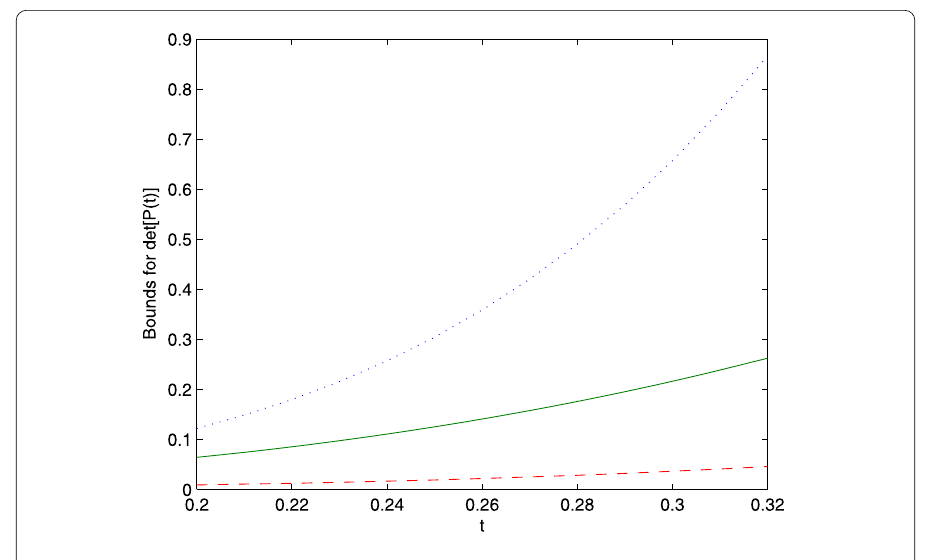
Figure 1 Eigenvalue bounds in Example 6.1